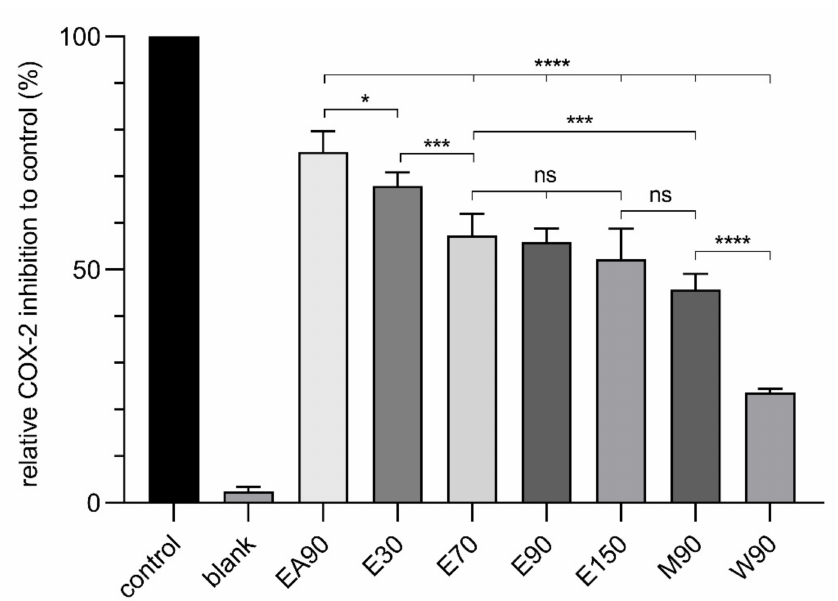
Figure 7. Relative COX-2 inhibition to control (%) of Waltheria indica extract solution (20 µ g/mL), blank (DMSO) and control set to 100% (0.5 µ M celecoxib). Data points represent the mean value ± standard deviations of six samples. Statistically different expressions were calculated using one-way ANOVA. (****): p < 0.0001; (***): p = 0.0005; (*): p = 0.0442; (ns): not